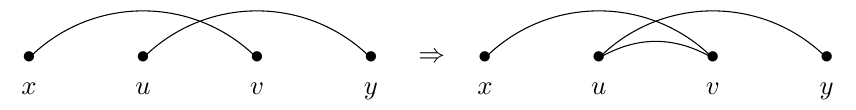
Fig. 2: Graphic representation of the four point condition for p -B OX (1)